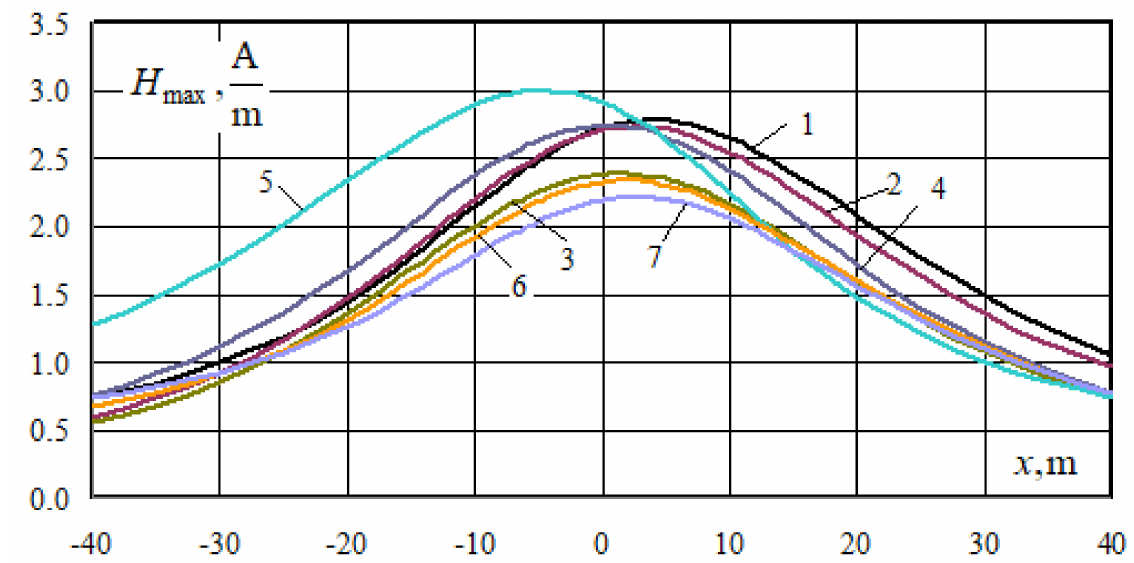
Figure 17. Magnetic field strength amplitudes at the beginning of the first section of the three-circuit line as a function of the coordinate x by phase sequence